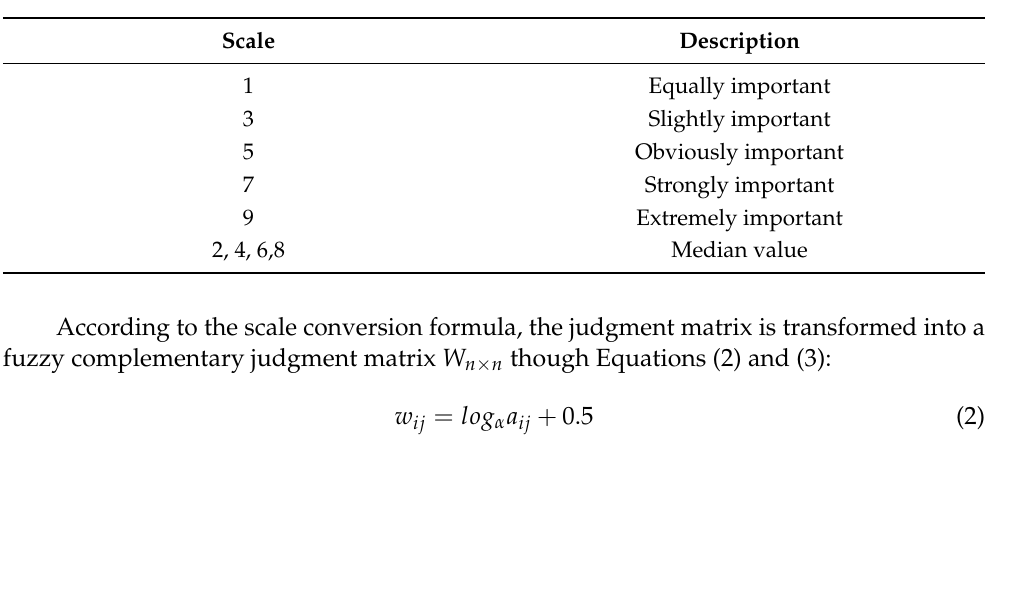
Table 1. Meanings of importance